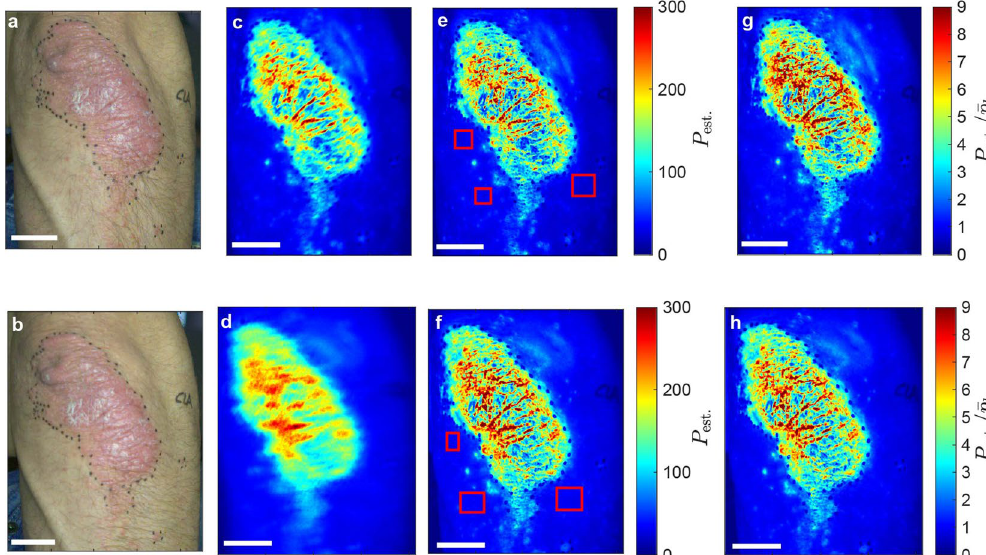
Figure 6. Visual comparison of a representative mounted (top row) and the corresponding handheld (bottom row) experiments. ( a , b ) RGB photographs. Scale bars, 25 mm. Temporally averaged perfusion maps ( c , d ) before and ( e , f ) after the alignment. Red rectangles indicate areas in which background perfusion values ( ¯ p b ) are calculated. P est. : estimated perfusion. ( g , h ) Background corrected perfusion maps. Data of experiment index 1 is